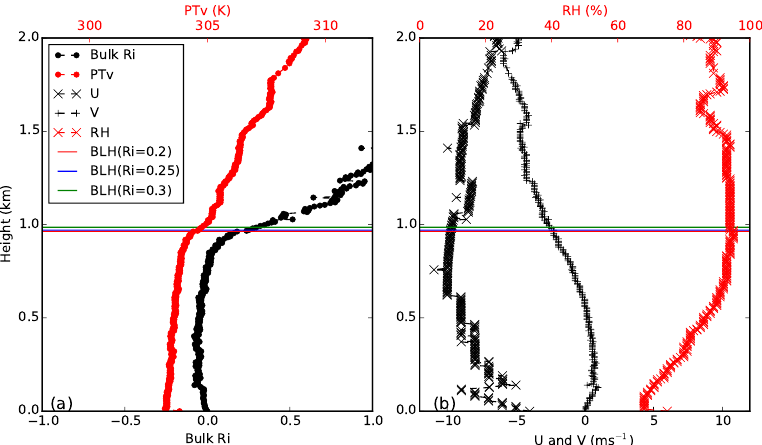
Figure 2. Vertical profile of (a) virtual potential temperature (PT v ), bulk Richardson number ( Ri ), (b) wind speed ( U and V ) and relative humidity (RH) based on the 20:00BJT 03 August 2012 radiosonde observation at the Beijing site. The horizontal lines indicate boundary layer heights (BLH) computed using 0.2 (red), 0.25 (blue) and 0.3 (green) as critical bulk Richardson number values.